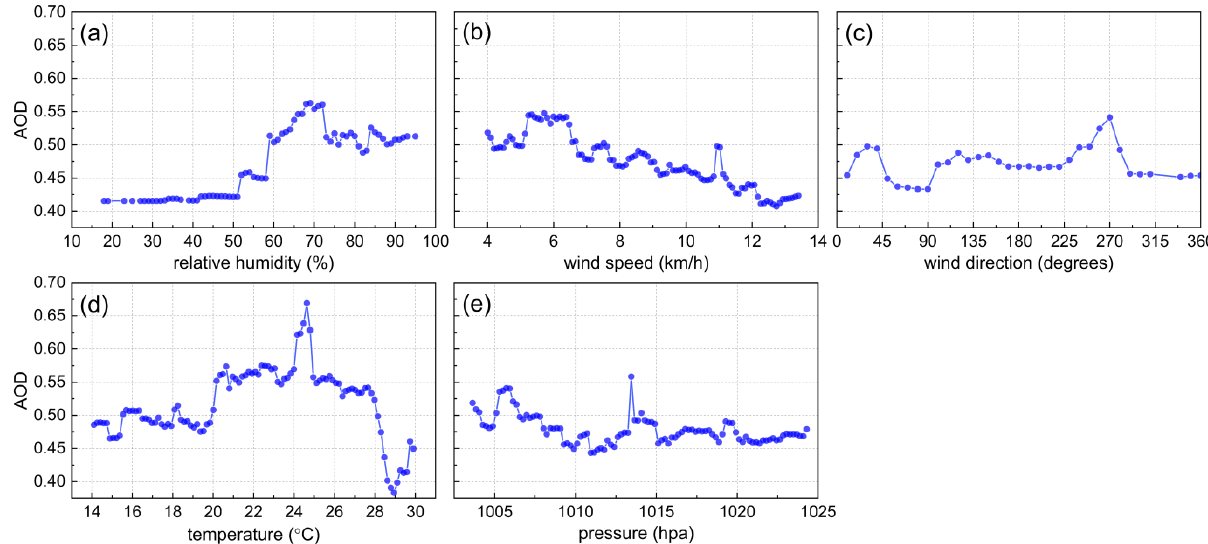
Figure 7. Interactions between AOD and meteorological factors derived by XGBoost.